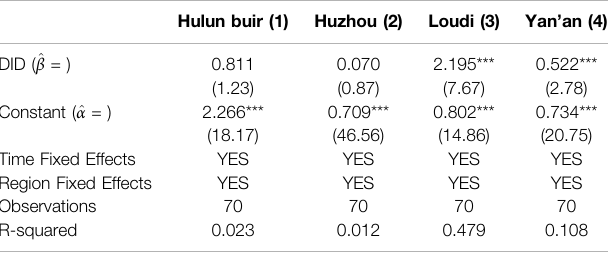
TABLE 5 | Regression results of CO 2 PerCapita .